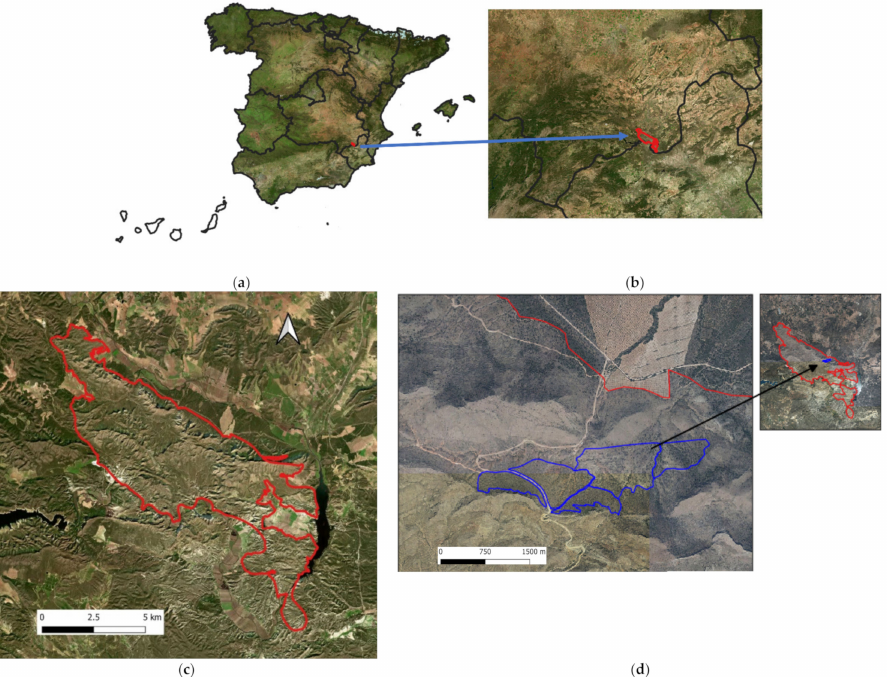
Figure 1. Location ( a ) and aerial map ( b ) of the study area, catchment area ( c ) and hillslope area ( d ) in Sierra de los Donceles forest (Castilla La Mancha,